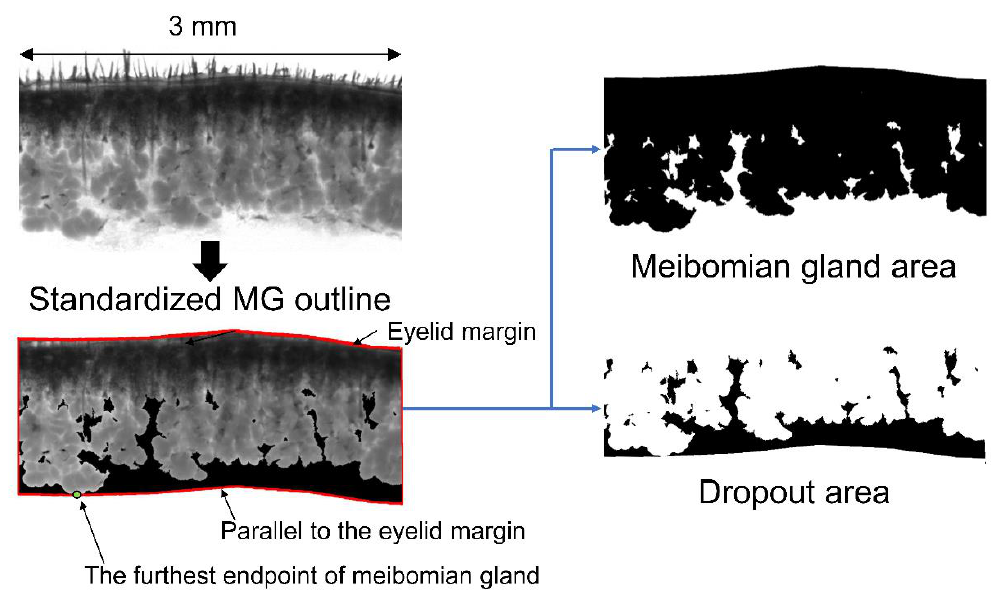
Figure 9. Ex vivo transillumination meibography images of the central 3-mm area of interest were analyzed. “The standardized MG outline” was defined with an imaginary line starting at the furthest endpoint of the MG and parallel to the eyelid margin. The area of the MG, including the eyelid margin, was defined as “the MG area”, and the area where the MG does not exist inside the standardized MG outline was defined as “the dropout area”.